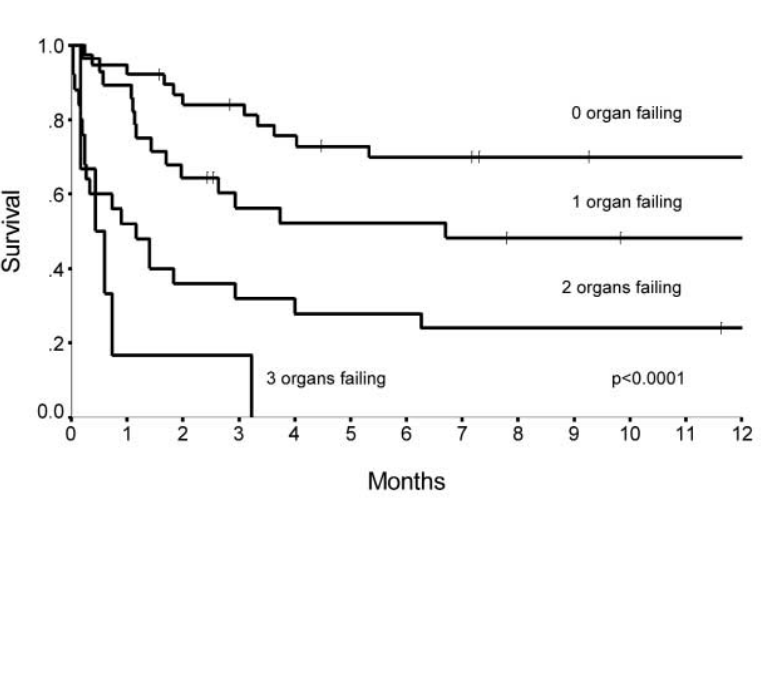
One year survival probabilities after ICU admission with 0, 1, 2, 3 failing